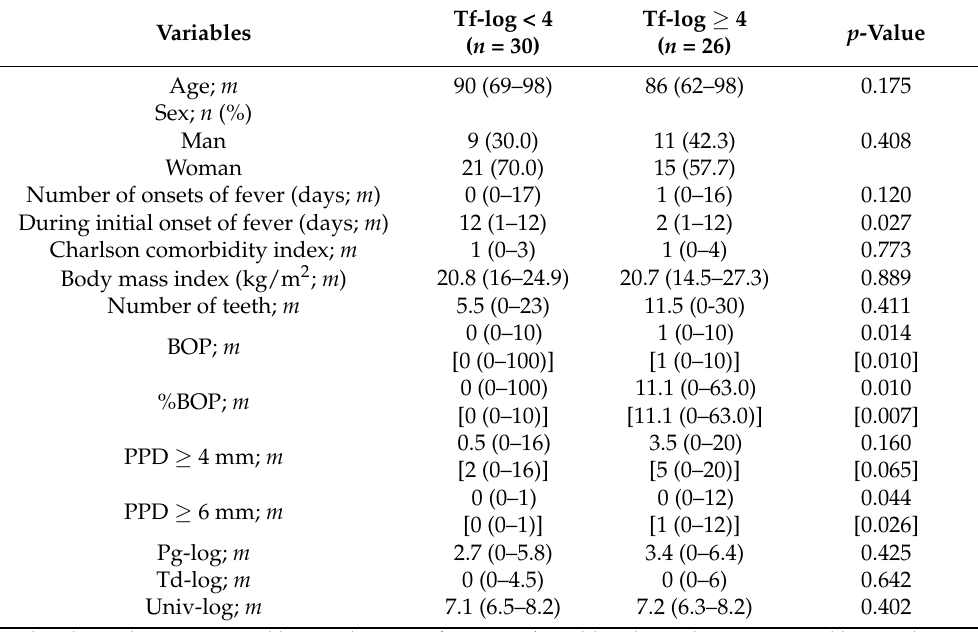
Table 3. Characteristics of